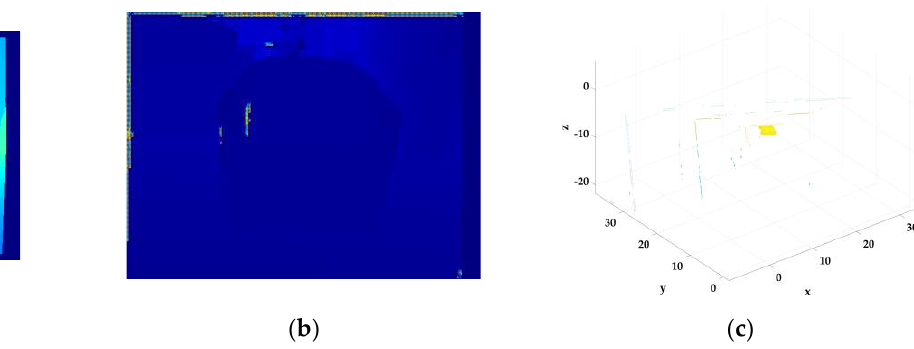
Figure 7. Kriging interpolation results for depth images (PSNR = 20.629 dB). ( a ), depth image; ( b ), depth image after Kriging interpolation; ( c ), point cloud map orthomosaic of the depth image.